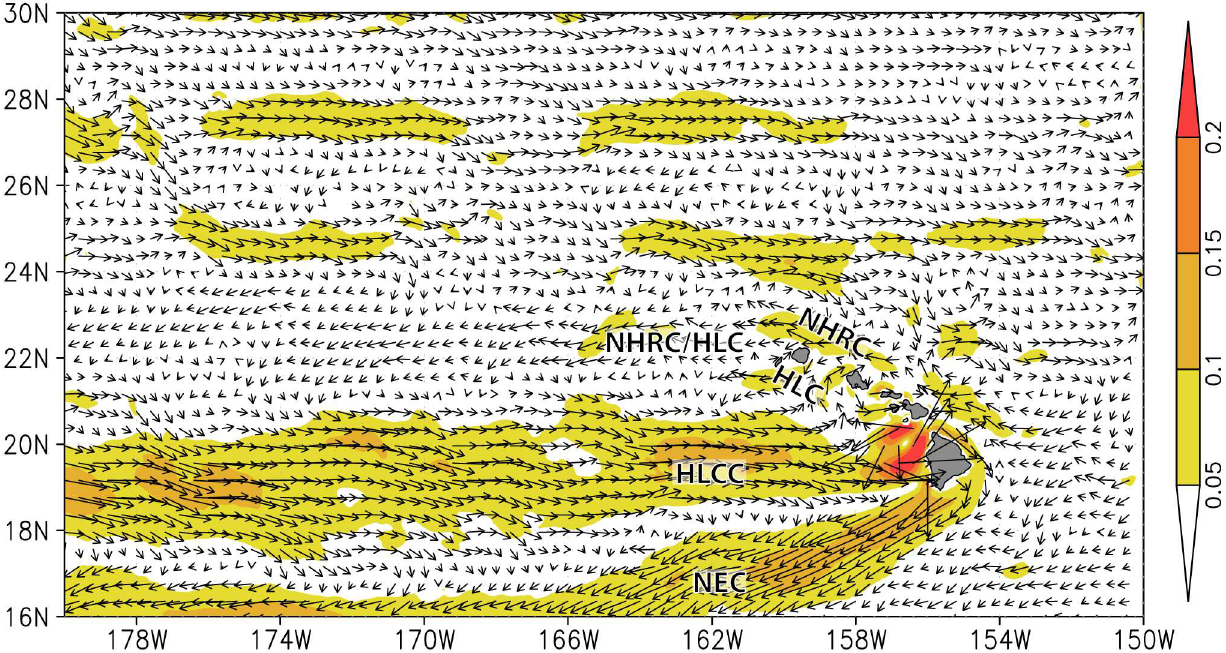
Fig 9. Modeled flow fields produced by the regional Hawai‘i MITgcm for May 2009-May 2014. Surface geostrophic currents (m/s) around the Hawaiian Archipelago. The eastward zonal flows are visible near 25˚N and 27˚N. Major surface currents are marked: Hawai‘iLee Counter Current (HLCC), Hawai‘i Lee Current (HLC), North EquatorialCurrent (NEC) and North Hawaiian Ridge Current (NHRC). Vectors show current velocitiesand colors denote current